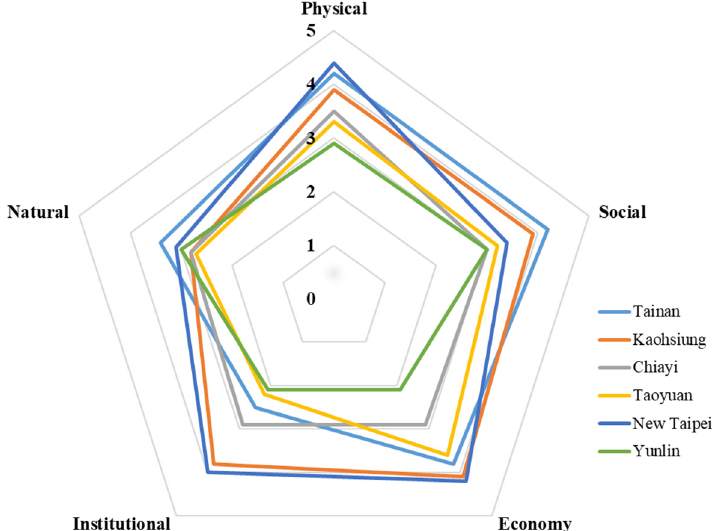
Figure 5. CDRI dimension scores in Tainan, Kaohsiung, Chiayi, Taoyuan, New Taipei, and Yunlin. Additionally, Yunlin County is the primary agricultural county in Taiwan. While rising sea levels cause coastal flooding, the coexistence of seawater intrusion and challenges associated with rainwater venting, resulting in significant agricultural and economic losses in central and southern regions, particularly Yunlin County. Furthermore, Yunlin County has been affected in recent years by climate change and artificial groundwater overexploitation, making coastal townships prone to flooding and severe subsidence